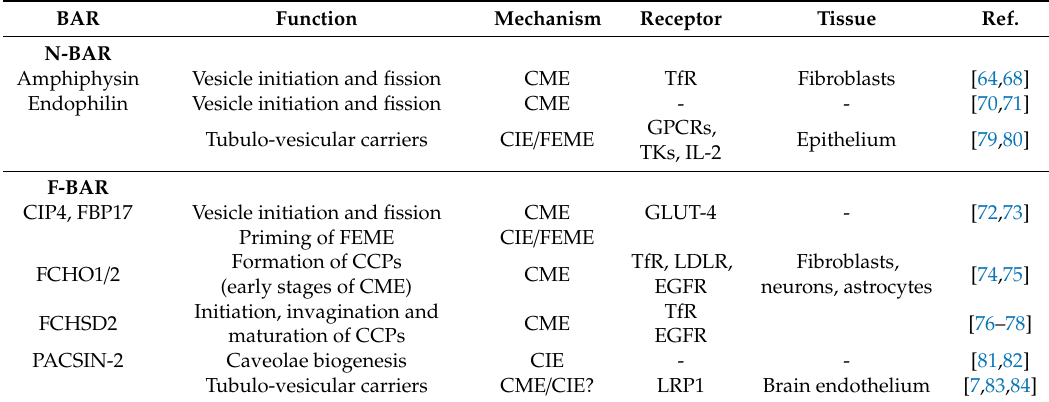
Table 4. N- and F-BAR proteins involved in transcytosis steps: endocytosis and tra ffi